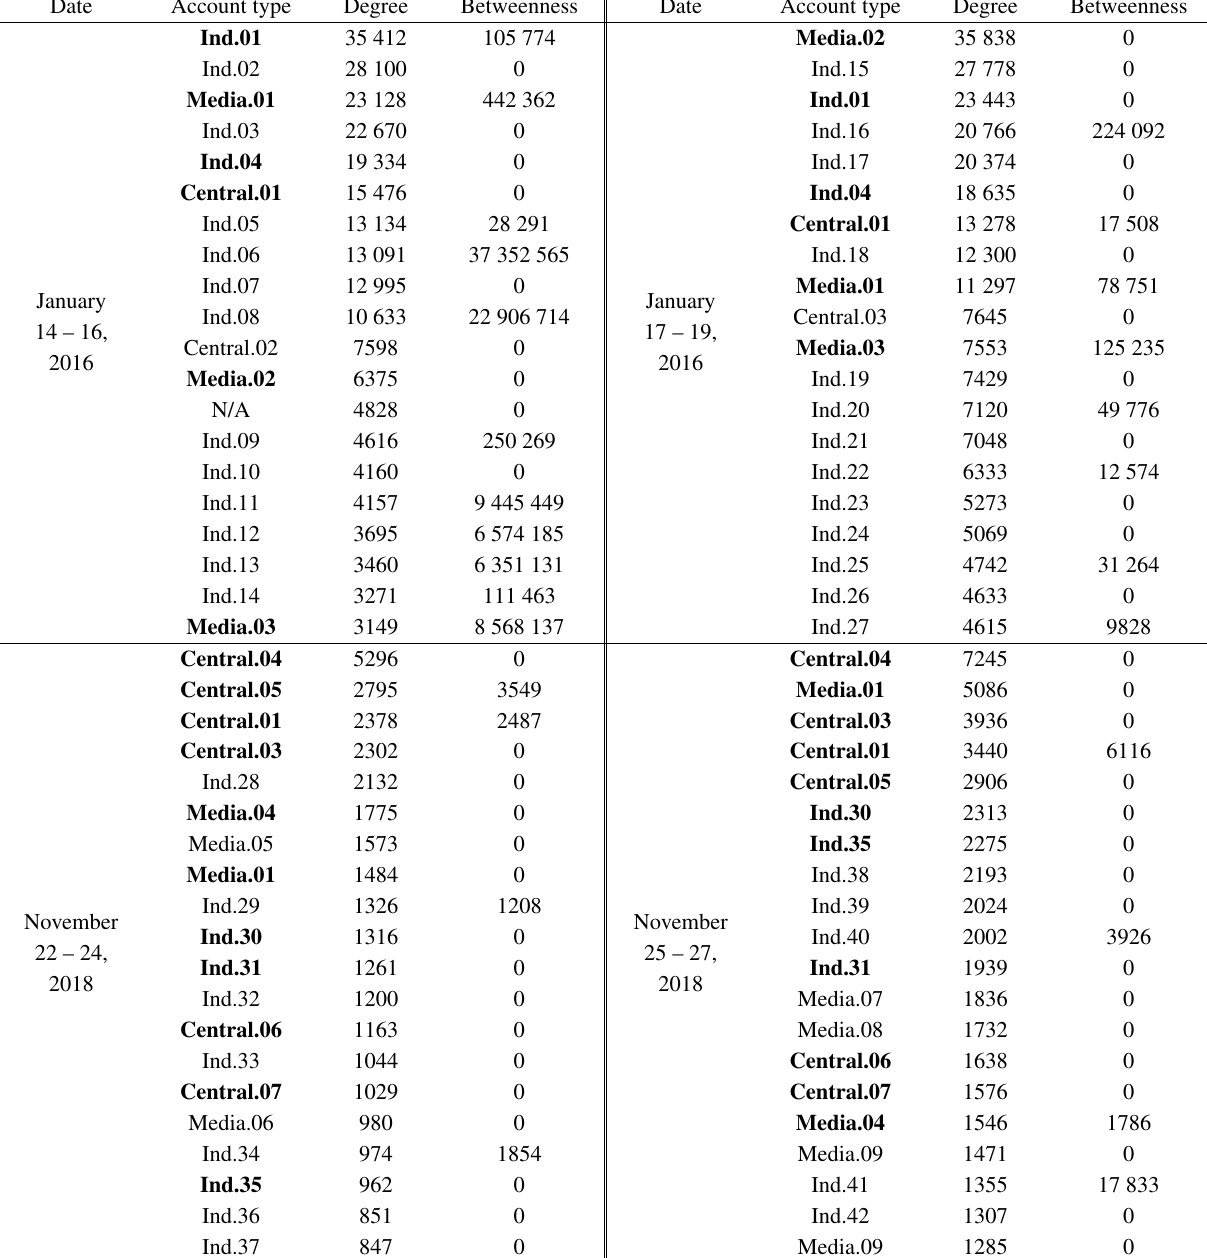
Table 2 Lists of nodes of the top 20 degrees in four periods. Ind., Media., and Central. represent individual (personal), local media, and central media accounts, respectively. The accounts of the top 20 degrees before and after the elections are both labeled in bold